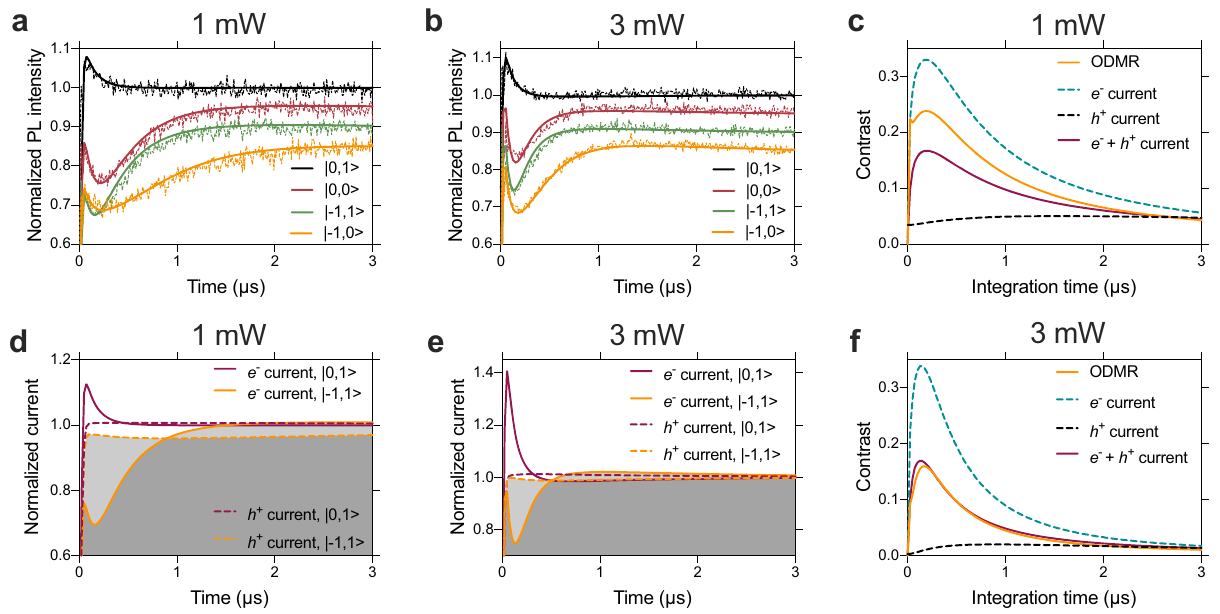
Fig. 3 Photon and charge carrier emission dynamics and intrinsic spin contrast. a , b The experimental (thin) and theoretical (bold) time traces of the normalized PL intensity upon turning on the laser excitation pulse of 1 and 3 mW power, respectively, for various initial electron and nuclear spin states. For a better visibility, the curves corresponding to |0,0 〉 , | − 1,1 〉 and | − 1,0 〉 initial states are shifted down by 0.05, 0.1 and 0.15, respectively. To prepare different initial spin states in the experiment, RF, MW0 and MW1 π -pulses were used (see Fig. 4a). The theoretical results closely follow the experimental curves. d , e The time traces of the simulated electron currents (solid lines) and hole currents (dashed lines) for 1 and 3 mW laser power, respectively, for |0,1 〉 and | − 1,1 〉 initial spin states. The curves are normalized to the steady-state electron current obtained for the |0,1 〉 initial spin state. The areas below the electron and hole currents (grey areas under the solid and dashed lines) are integrated to the same value to ensure the charge neutrality constraint of the photoionization cycle. The difference between the solid (dashed) curves provides the spin contrast of the electron (hole) current. c , f The theoretical ODMR contrast and the contrast of the electron-only current, the hole-only current, and the total current (PDMR) as a function of integration time for 1 and 3 mW excitation power, respectively. In the case of ODMR and PDMR, the contribution of the experimental background signal is taken into consideration as well.